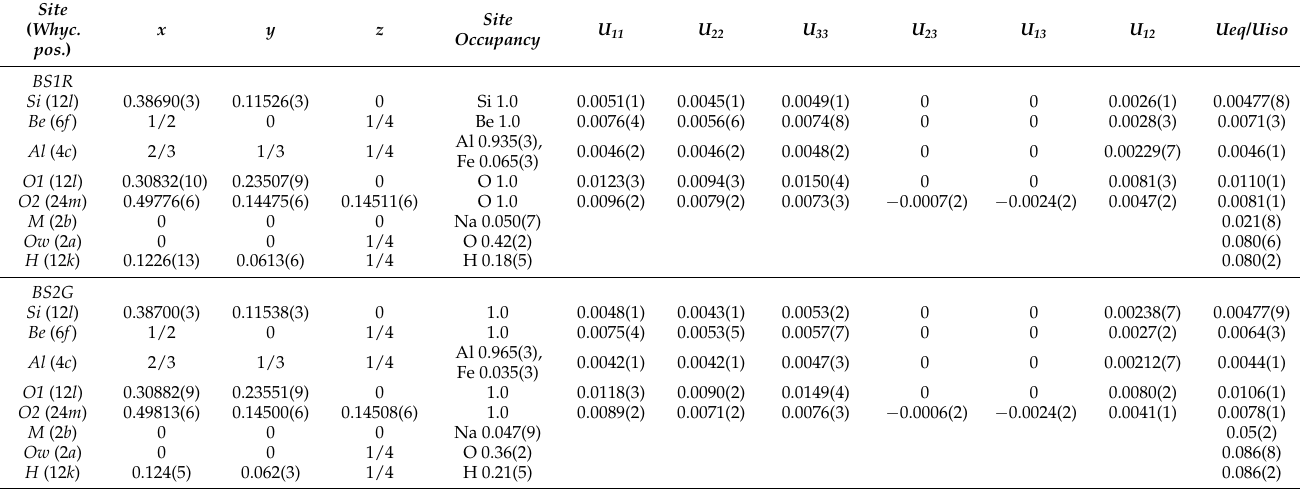
Table 4. Refined positional and displacement parameters (Å 2 ) of the beryl samples, based on single- crystal XRD data. The anisotropic displacement factor exponent takes the form: − 2 π 2 [( ha *) 2 U 11 + . .